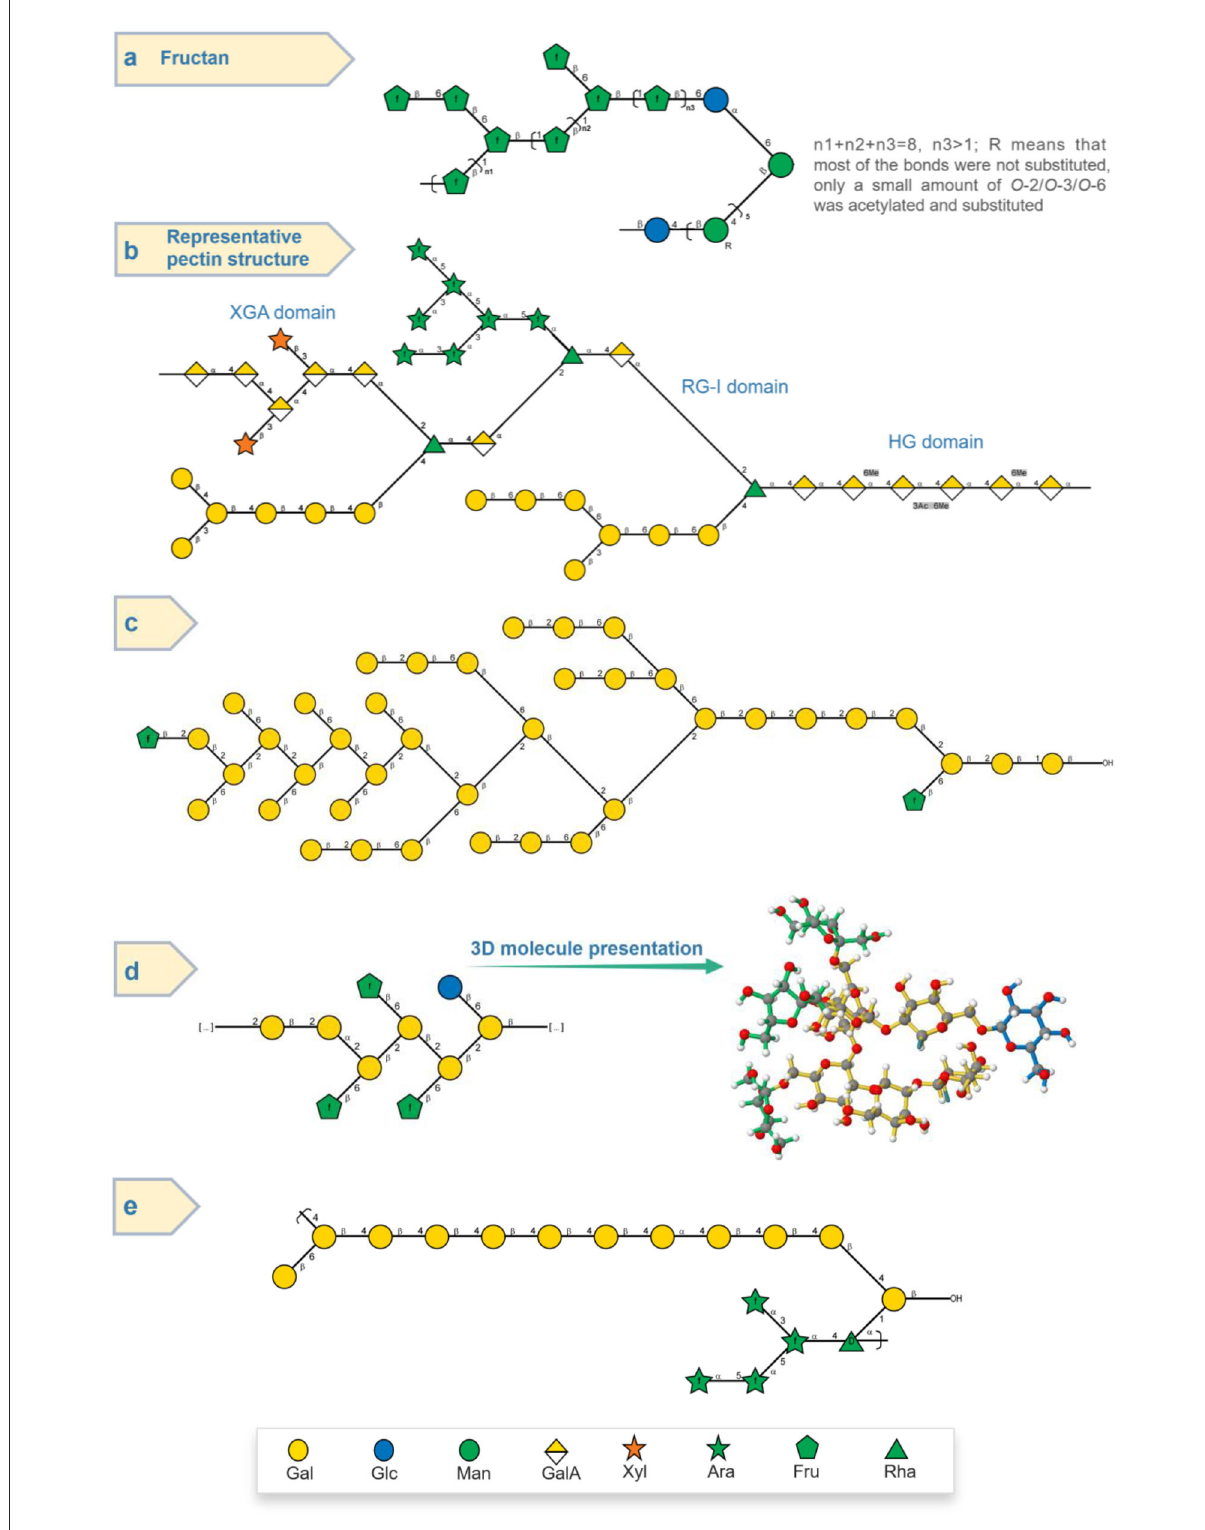
FIGURE4 Structure presentation of different PSPs in Symbol Nomenclature for Glycans (SNFG) according to current studies. (a) Fructan-type PSP (23). (b) Representable pectin structure with homogalacturonan (HG), rhamnogalacturonan I (RG-I), and xylogalacturonan (XGA) domains. (c,d) Two novel PSPs (15). (e) Arabinogalactan-type PSP